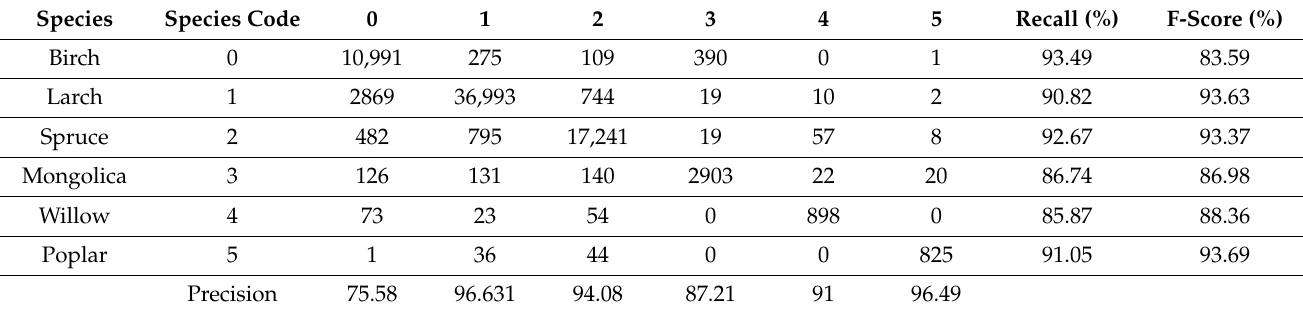
Table 8. The tree classification confusion matrix for tree species classification using ground truth (rows) compared to the DBMF model species prediction (columns; numbered labels refer to species numbers shown in row